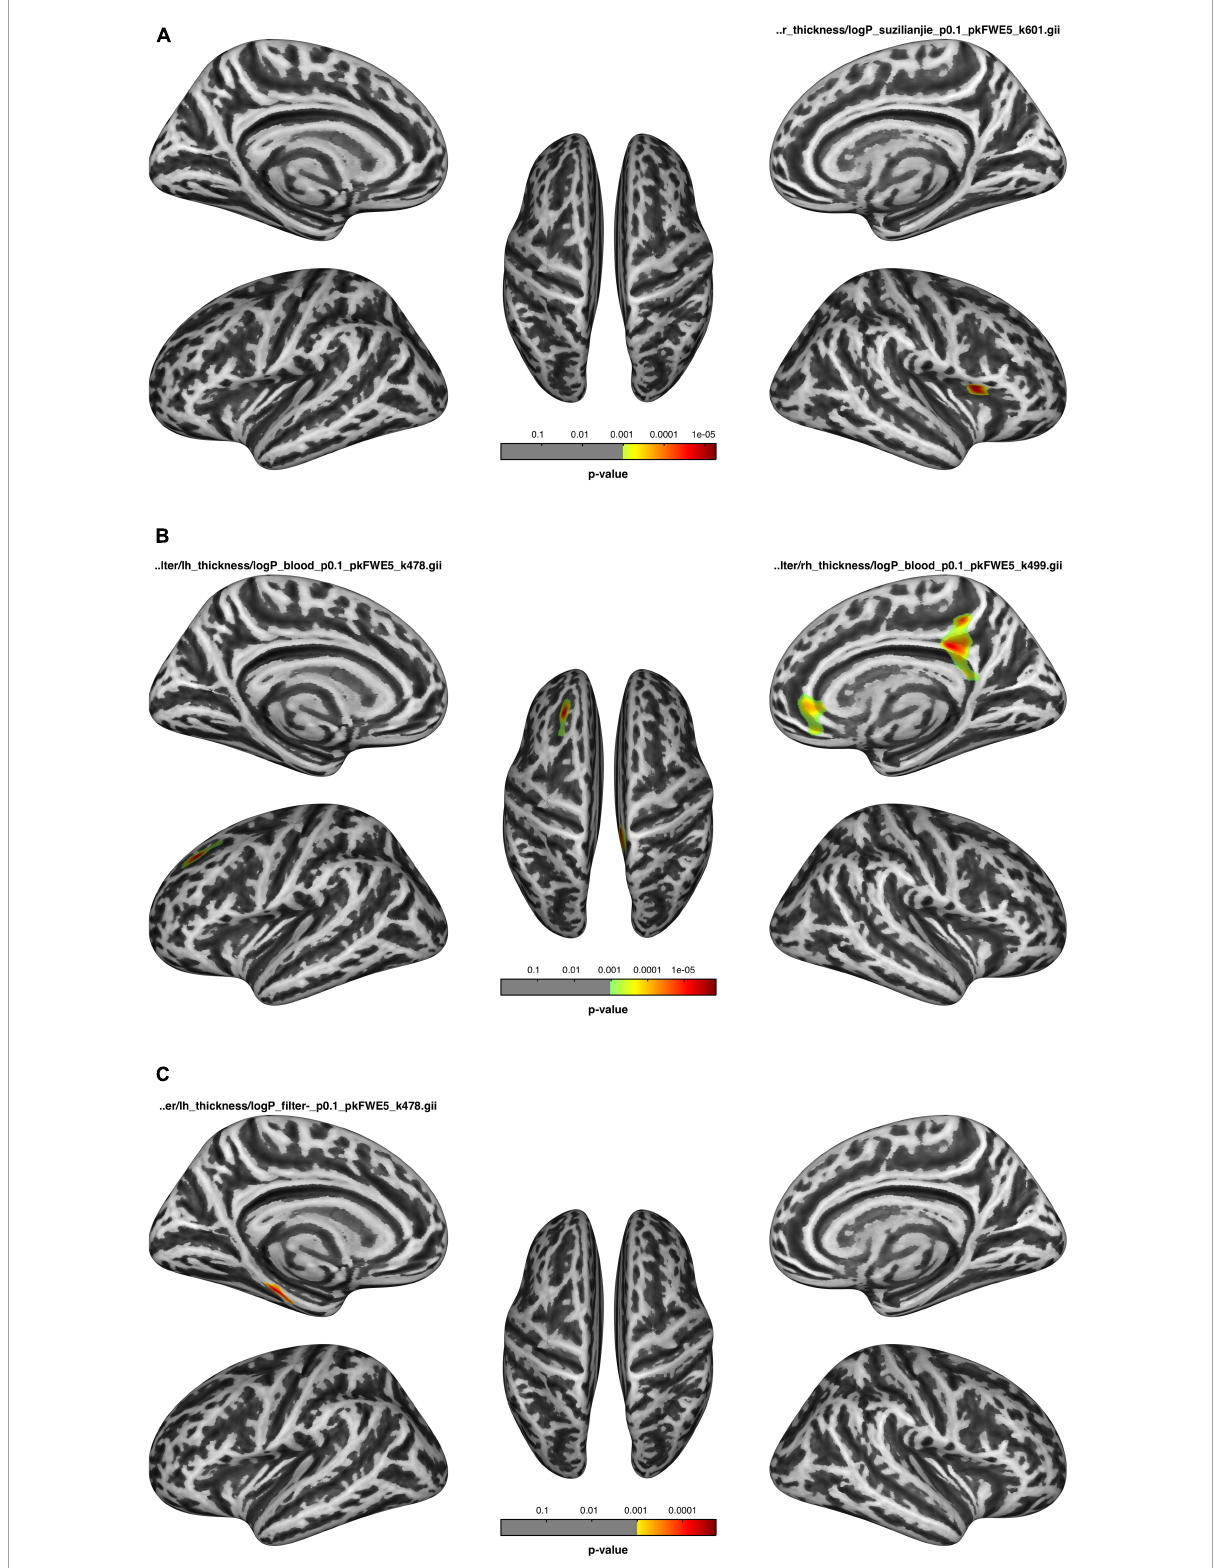
FIGURE3 After dialysis, (A) the thickness of the regions correlated with the number connection test-A (NCT-A); (B) the thickness of the regions correlated with blood flow velocity; (C) the thickness of the regions negatively correlated with ultrafiltration